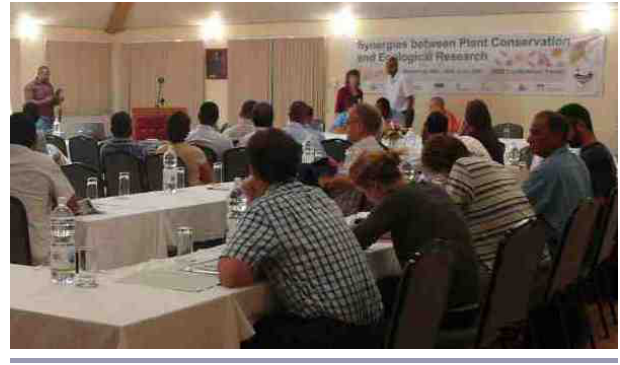
Fig. 5. Continuous research partnerships enable reciprocal learning and knowledge exchange between researchers and practitioners and ensure legitimate and salient research and effective outreach. The photograph shows scientists and practitioners at a workshop on future research priorities as part of a 15-yr research collaboration between ETH Zurich, the Ministry of Environment, and several nongovernmental organizations in Seychelles (Western Indian Ocean) on the management of tropical forests and plant